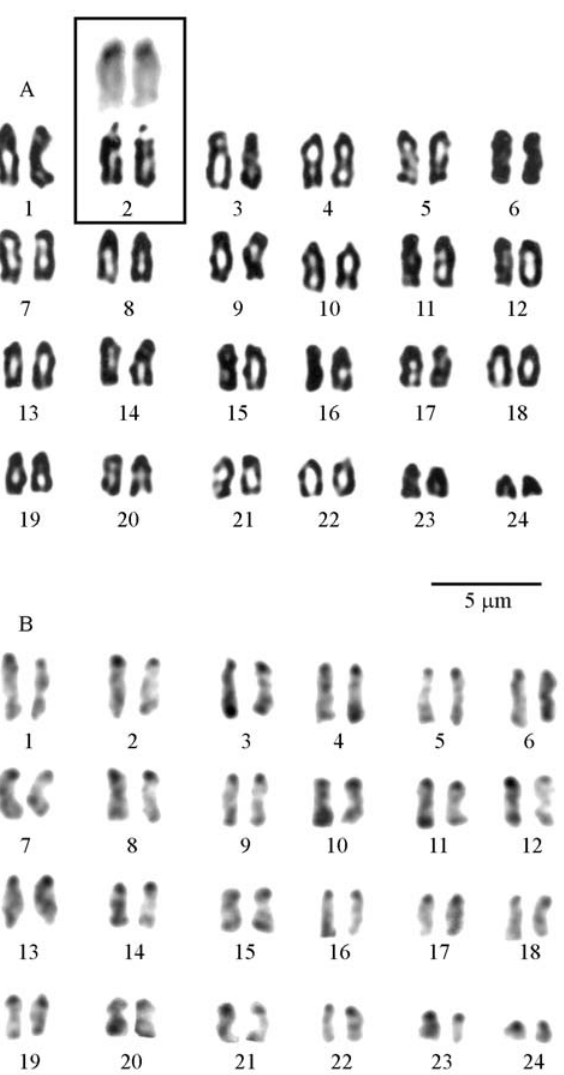
Figure3 -Karyotypeof Lutjanusjocu .(A)ConventionalGiemsastaining. In detail, the NOR-bearing pairs. (B) C-banding in L. jocu